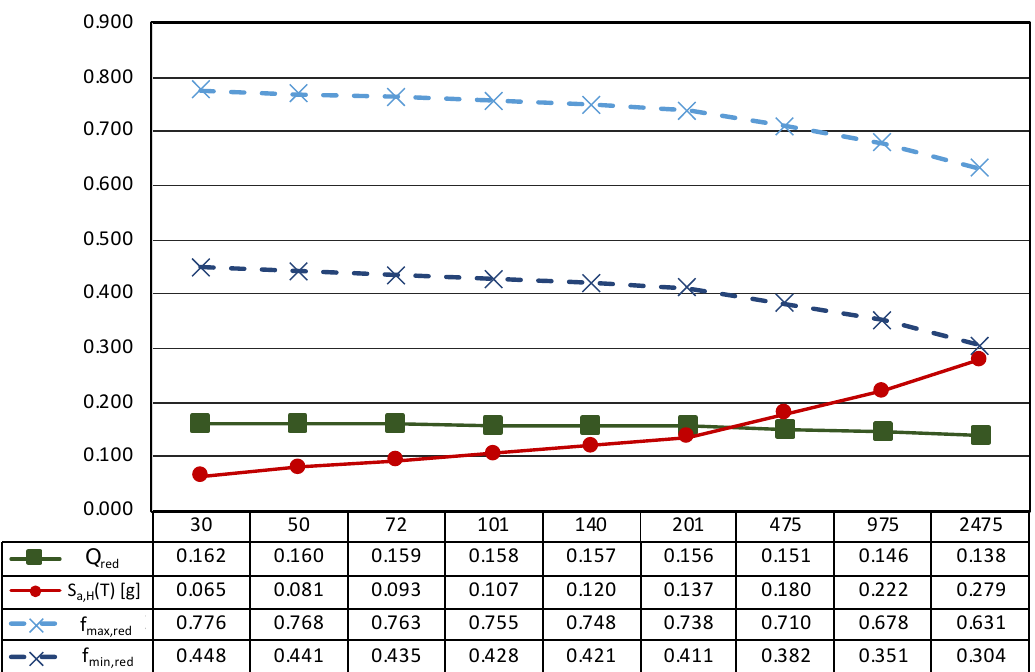
Figure 21. Results of the seismic performance assessment of the Resting Satyr under horizontal shaking only.